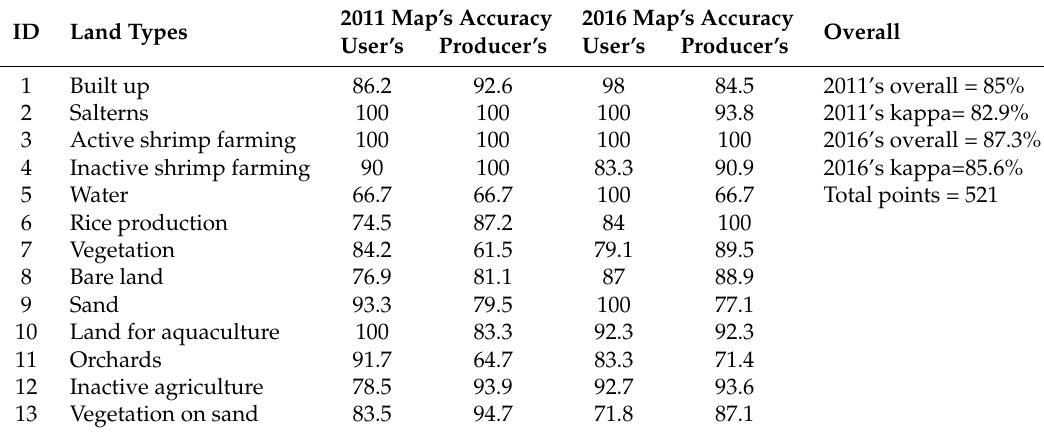
Table 3. Statistical summary from contingency tables generated to assess accuracy of two land use maps in 2011 and 2016. Unit:%.